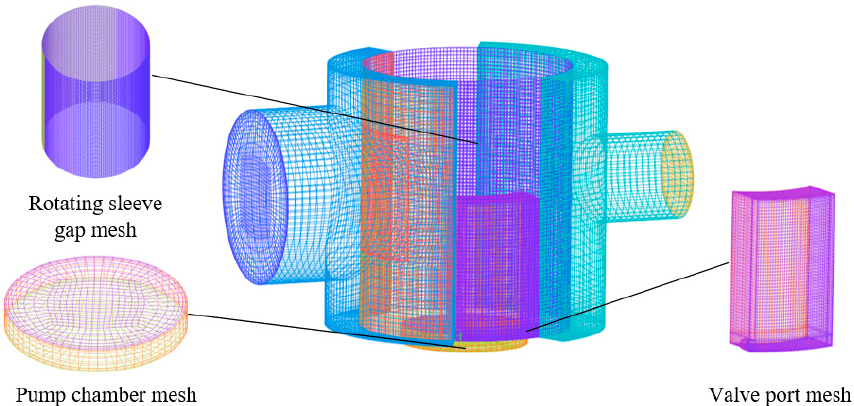
Figure 6. Fluid mesh model.